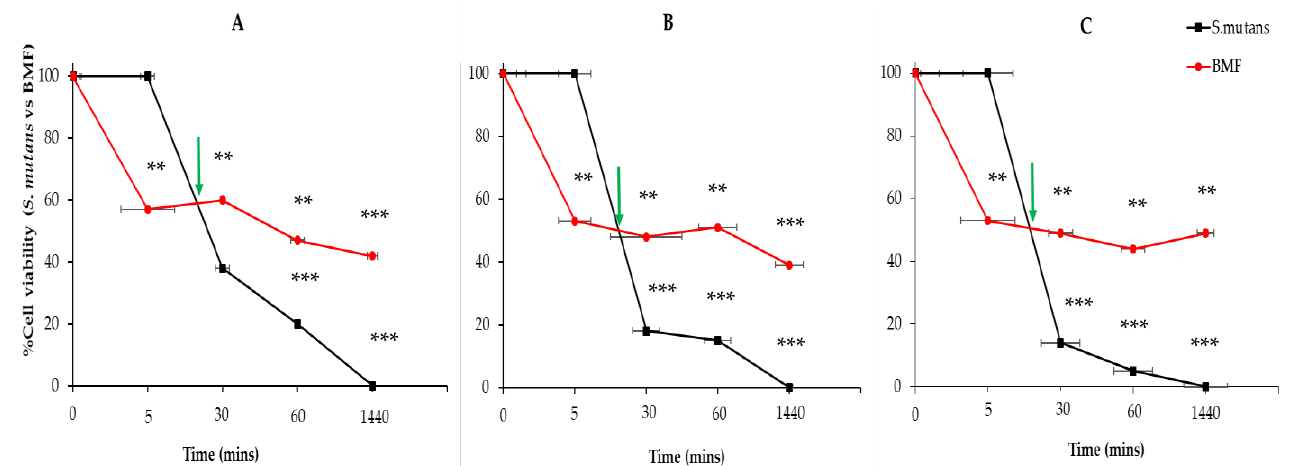
Figure 4. Comparison of the survival of S. mutans versus BMF cells after exposure to GA-AgNPs_TP-1. S. mutans and BMF cells were treated with 25 ( A ), 50 ( B ) and 100 ( C ) µg/mL for various time points up to 24 h. Viability was evaluated by MTT assay. The green arrow points at an equivalence point of the GA-AgNPs_TP-1. p ≤ 0.05 was considered as statistically significant, ** p ≤ 0.01 and *** p ≤ 0.001.